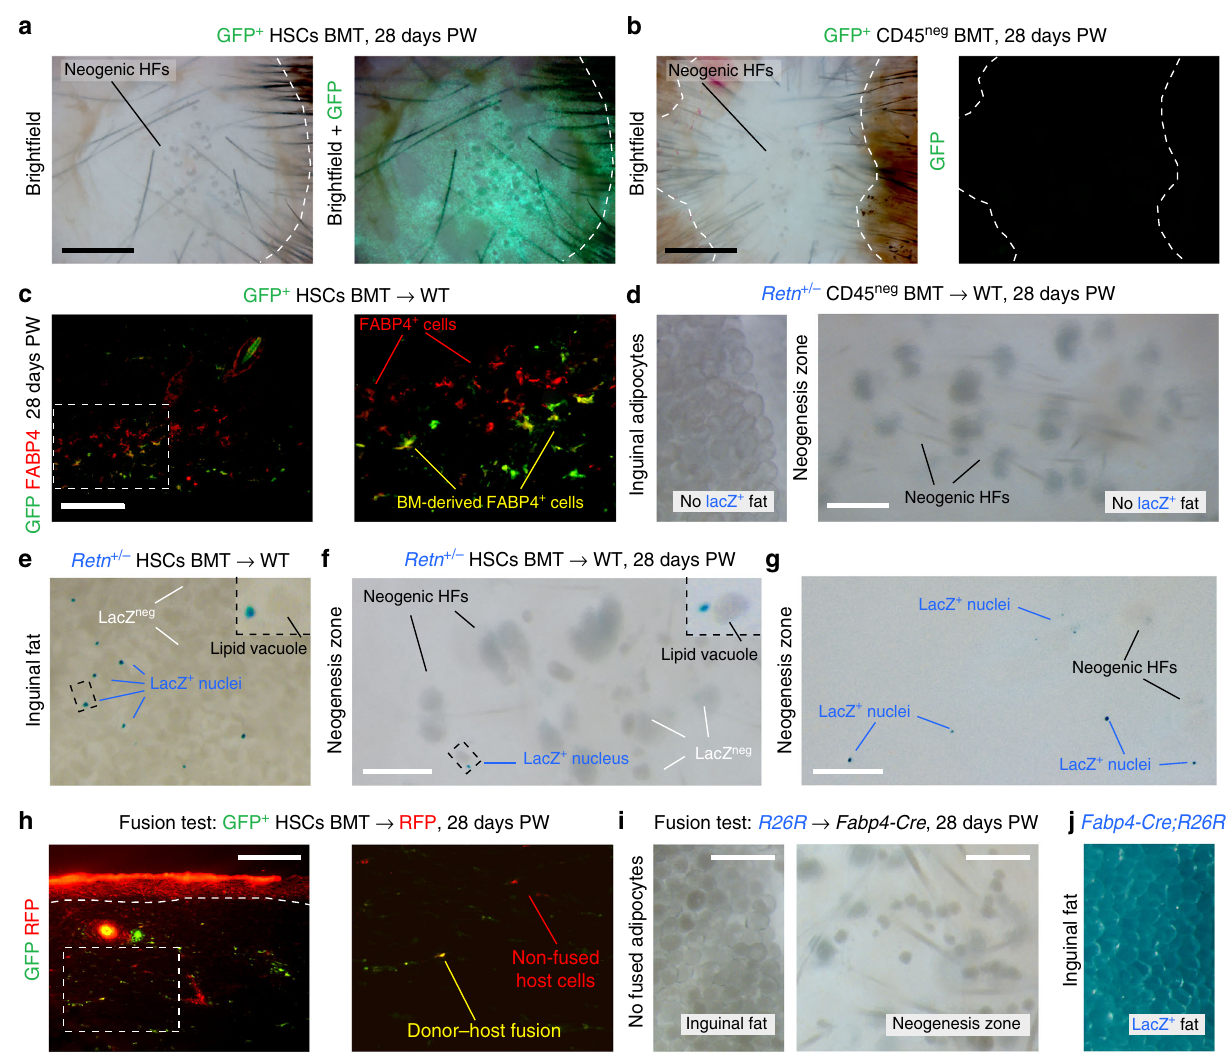
Fig. 7 Hematopoietic lineage cells contribute to rare de novo adipocytes. a , b GFP expressing cells in GFP + HSCs BMT mice ( a ), but not in GFP + CD45 neg BMT mice ( b ), showed signi fi cant contribution to the areas of neogenesis 28 days PW. See also Supplementary Figure 19. c In the wounds of GFP + HSCs BMT mice, GFP + cells localize around neogenic hair follicles and a portion of them co-expresses FABP4 at 28 days PW. Image is representative of the marker staining pattern observed in three or more independently stained samples. d CD45 neg BM cells do not contribute toward adipocytes in the inguinal fat or regenerated 28 days PW wounds of BMT mice reconstituted with Retn-lacZ CD45 neg cells. e – g In contrast, hematopoietic lineage cells consistently contributed toward rare adipocytes (cells with nuclear lacZ expression) in the inguinal fat ( e ) and regenerated 28 days PW wounds ( f , g ) of BMT mice reconstituted with Retn-lacZ HSCs. Insets on e and f show positive adipocytes with lipid vacuole and peripherally-positioned lacZ + nucleus. h Only rare